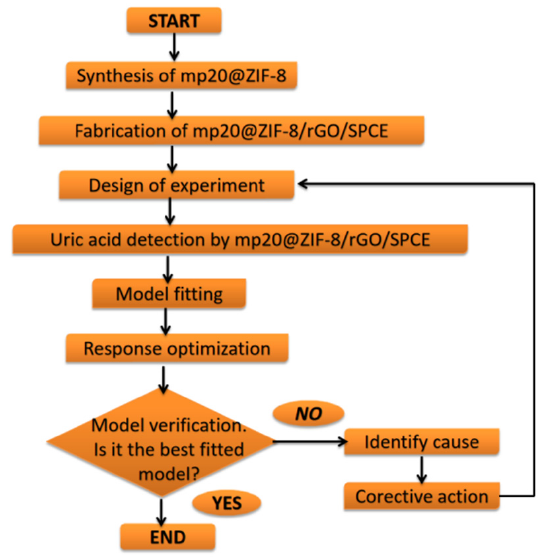
Figure 1. Flow chart of RSM optimization studies for uric acid detection based on mp20@ZIF- 8/rGO/SPCE electrode.